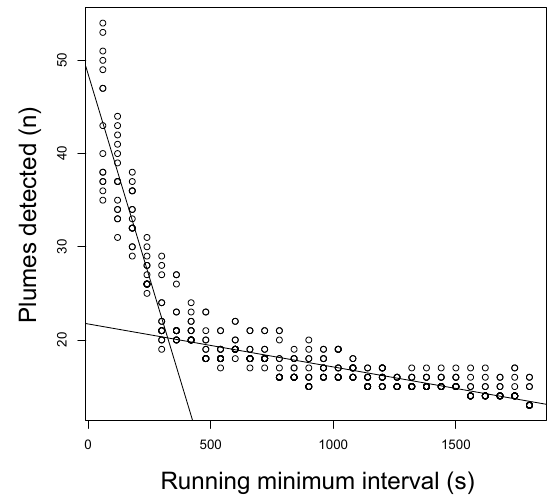
Figure 2. Example of a regression plot that demonstrates the opti- mization process we used to calculate an RMRI for each survey. The RMRI for each survey was chosen where the two linear regression lines